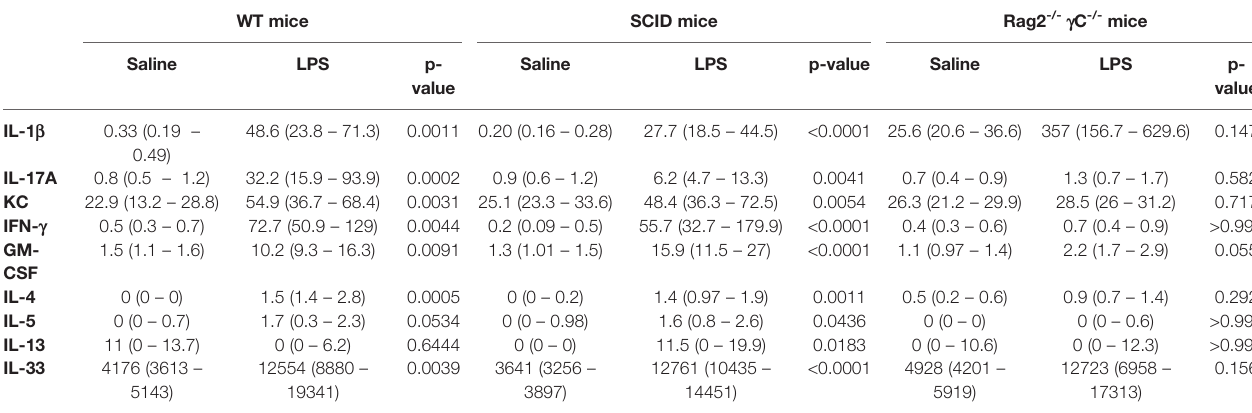
TABLE 2 | Lung cytokine production in lung tissue of wild-type BALB/c mice, SCID mice, and Rag2 -/- g C -/- mice nasally exposed to saline or LPS. WT mice SCID mice Rag2 -/- g C -/-